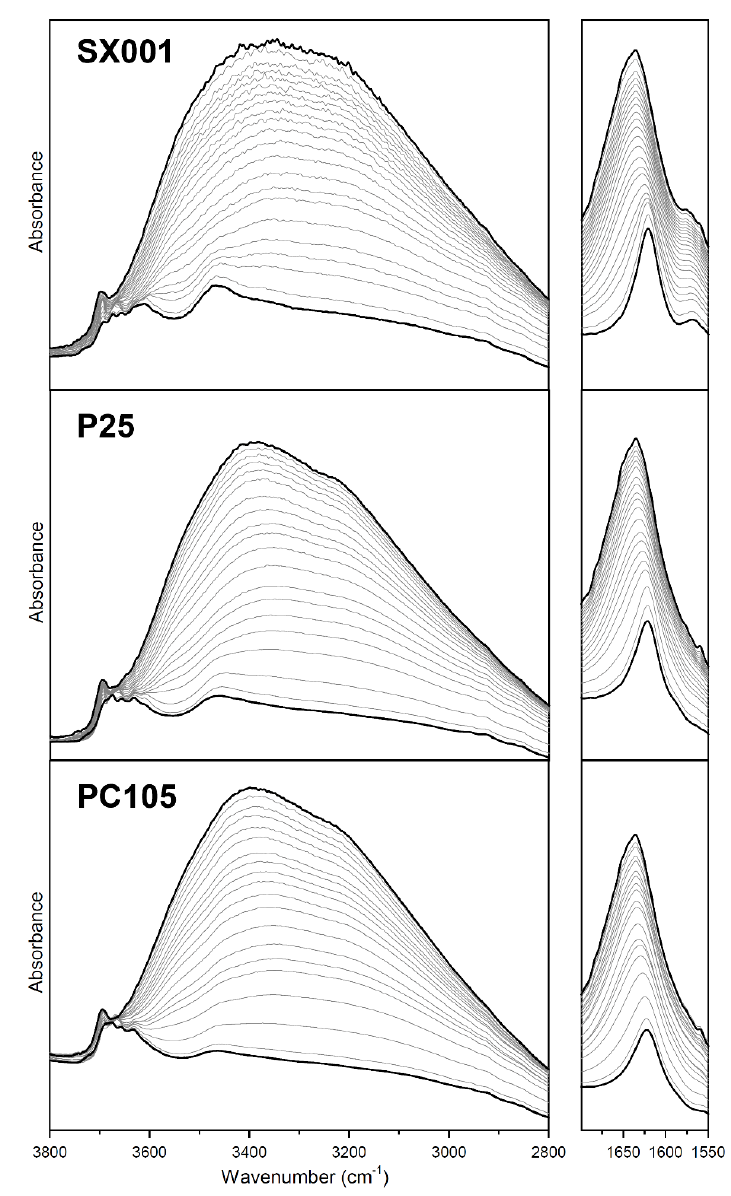
Figure 4. MIR spectra of the different materials, after activation at 873 K, in contact with H 2 O at 15 mbar (curve a) and progressive decreasing of the water coverage till outgassing H 2 O for 15 min at beam temperature (curve s).